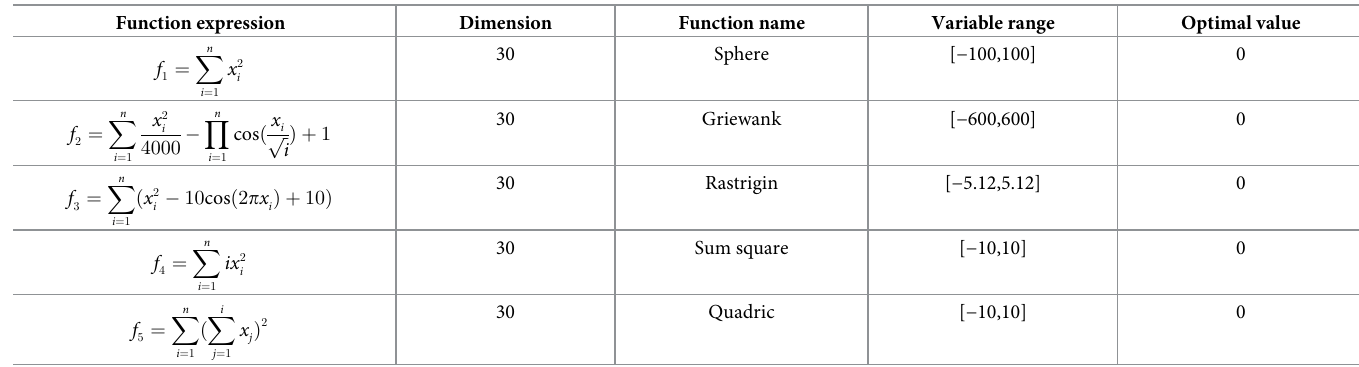
Table 1. Test functions. Function